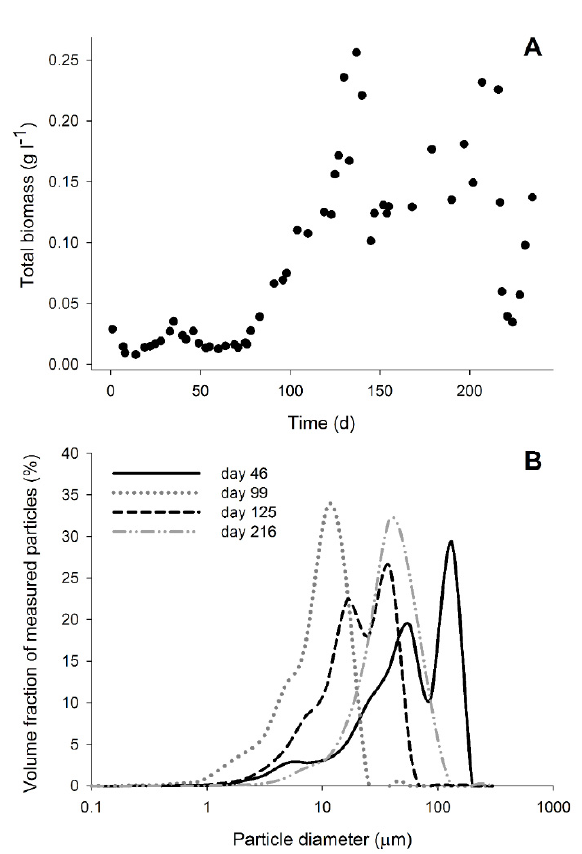
Figure 4. Biomass in the bioreactor. ( A ) Total biomass concentration (C tx ) in the bioreactor during its operation. ( B ) Particle diameter distribution of the biomass on days 46 (without CO), 99 (5% CO), 125 (just after increase to 15%), and 216 (stable phase with 15%